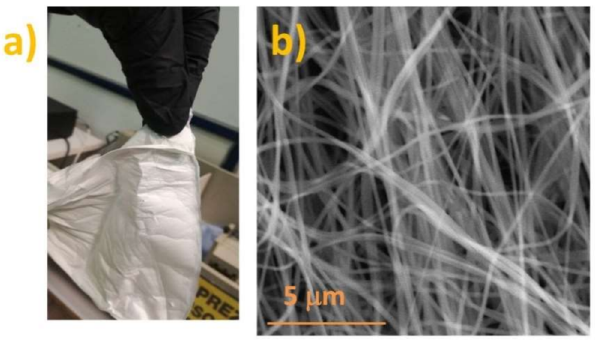
Figure 1. Photo ( a ) and SEM image ( b ) of as-spun fiber peeled off the baking